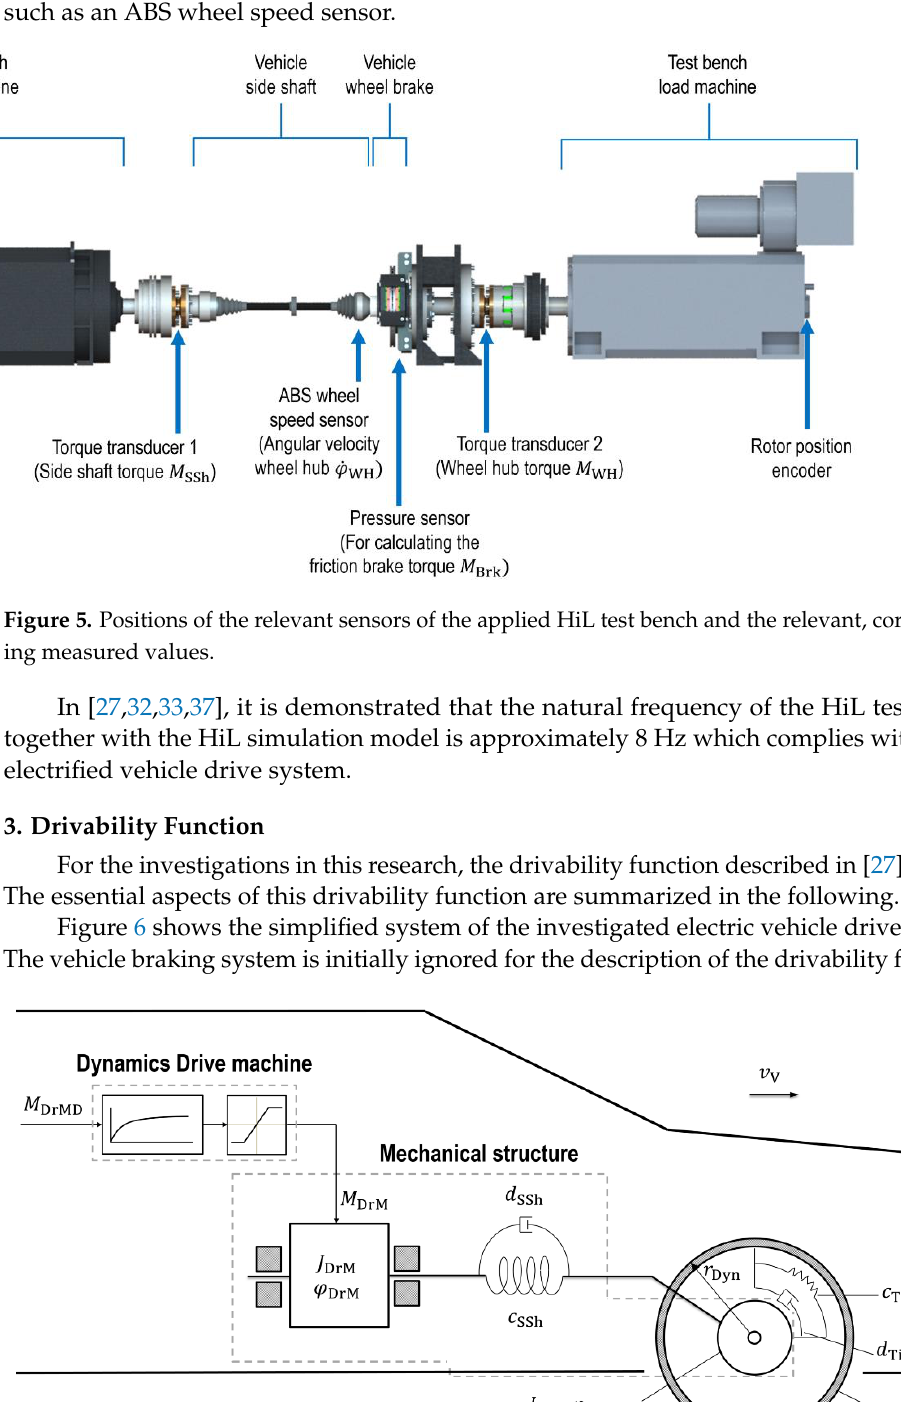
Figure 4. Schema of an electric single-wheel drive with gearbox and HiL test bench without gearbox.